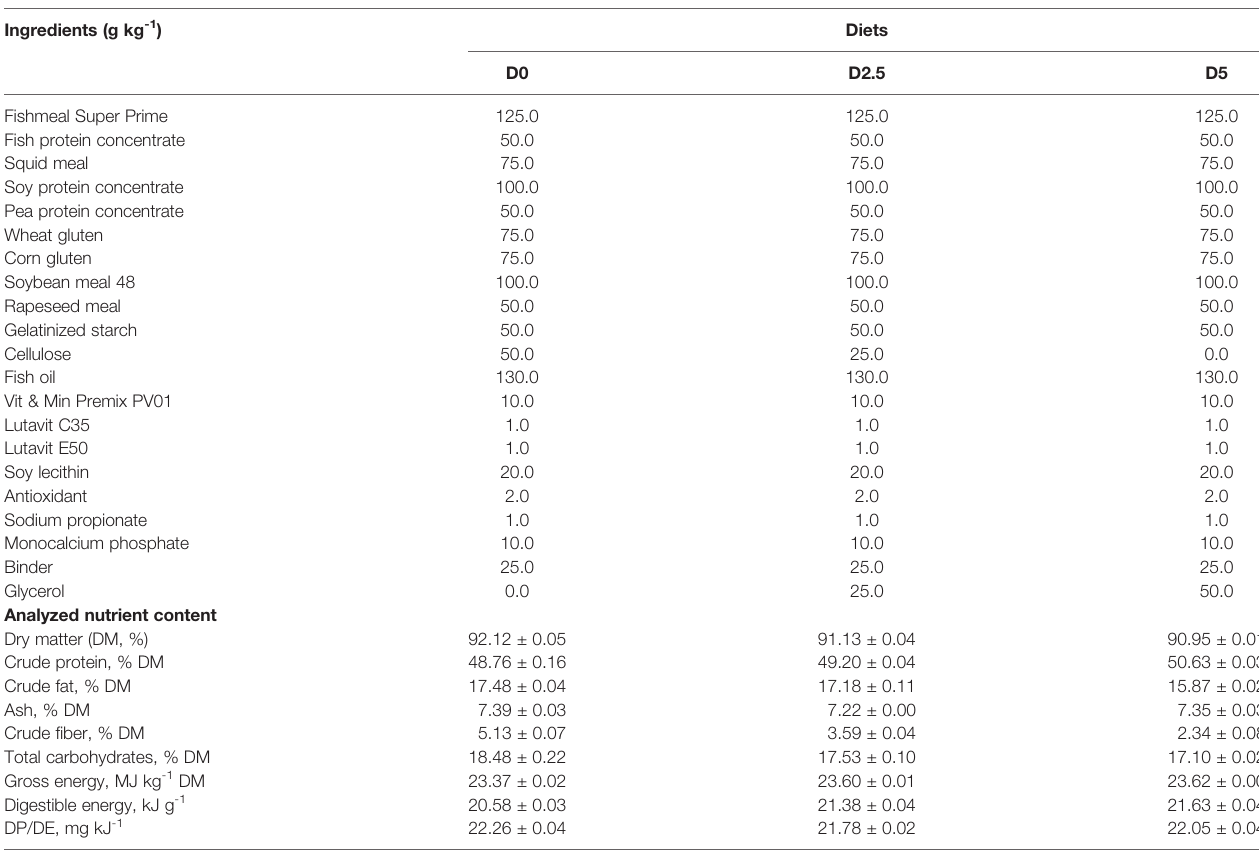
TABLE 1 | Ingredients and nutrient content of the diets. Ingredients (g kg -1 )